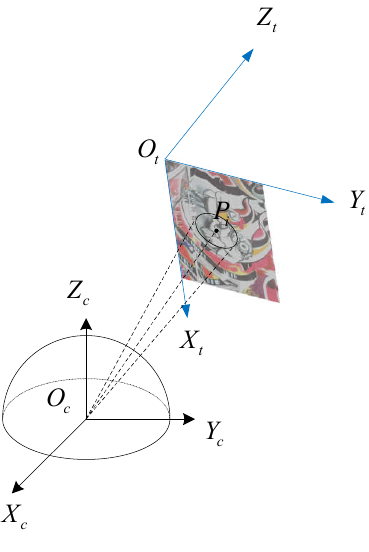
Figure A3. Position relationship between the camera coordinate system and the test image coordinate